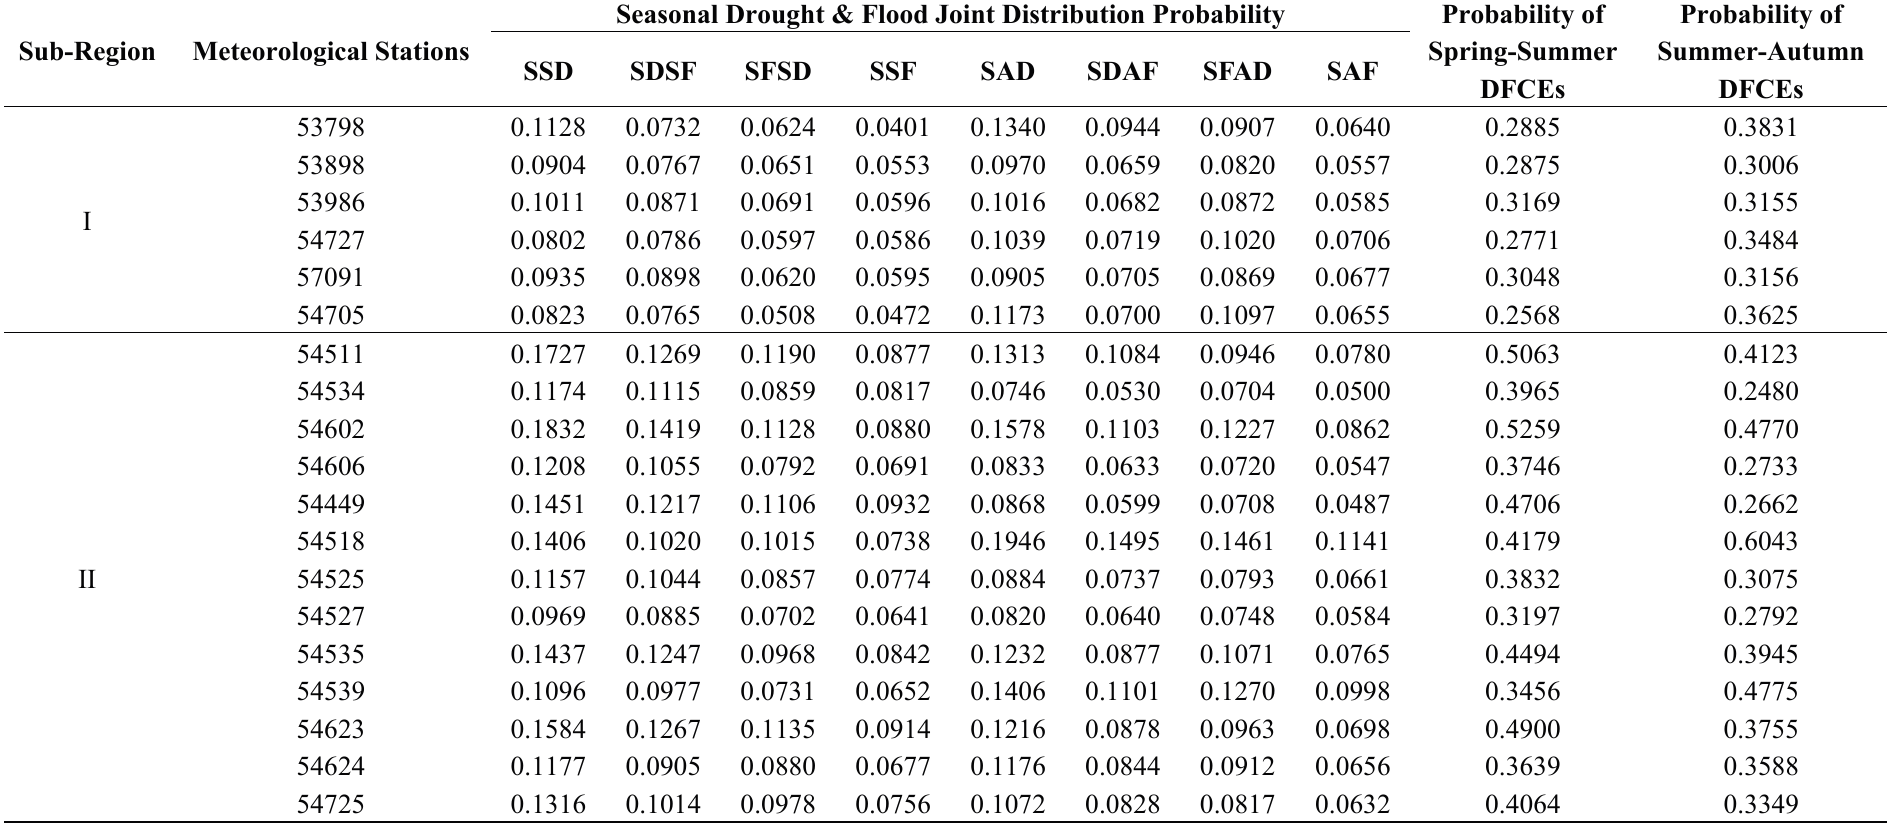
Table 10. Computed result of joint distribution of DFCEs on the